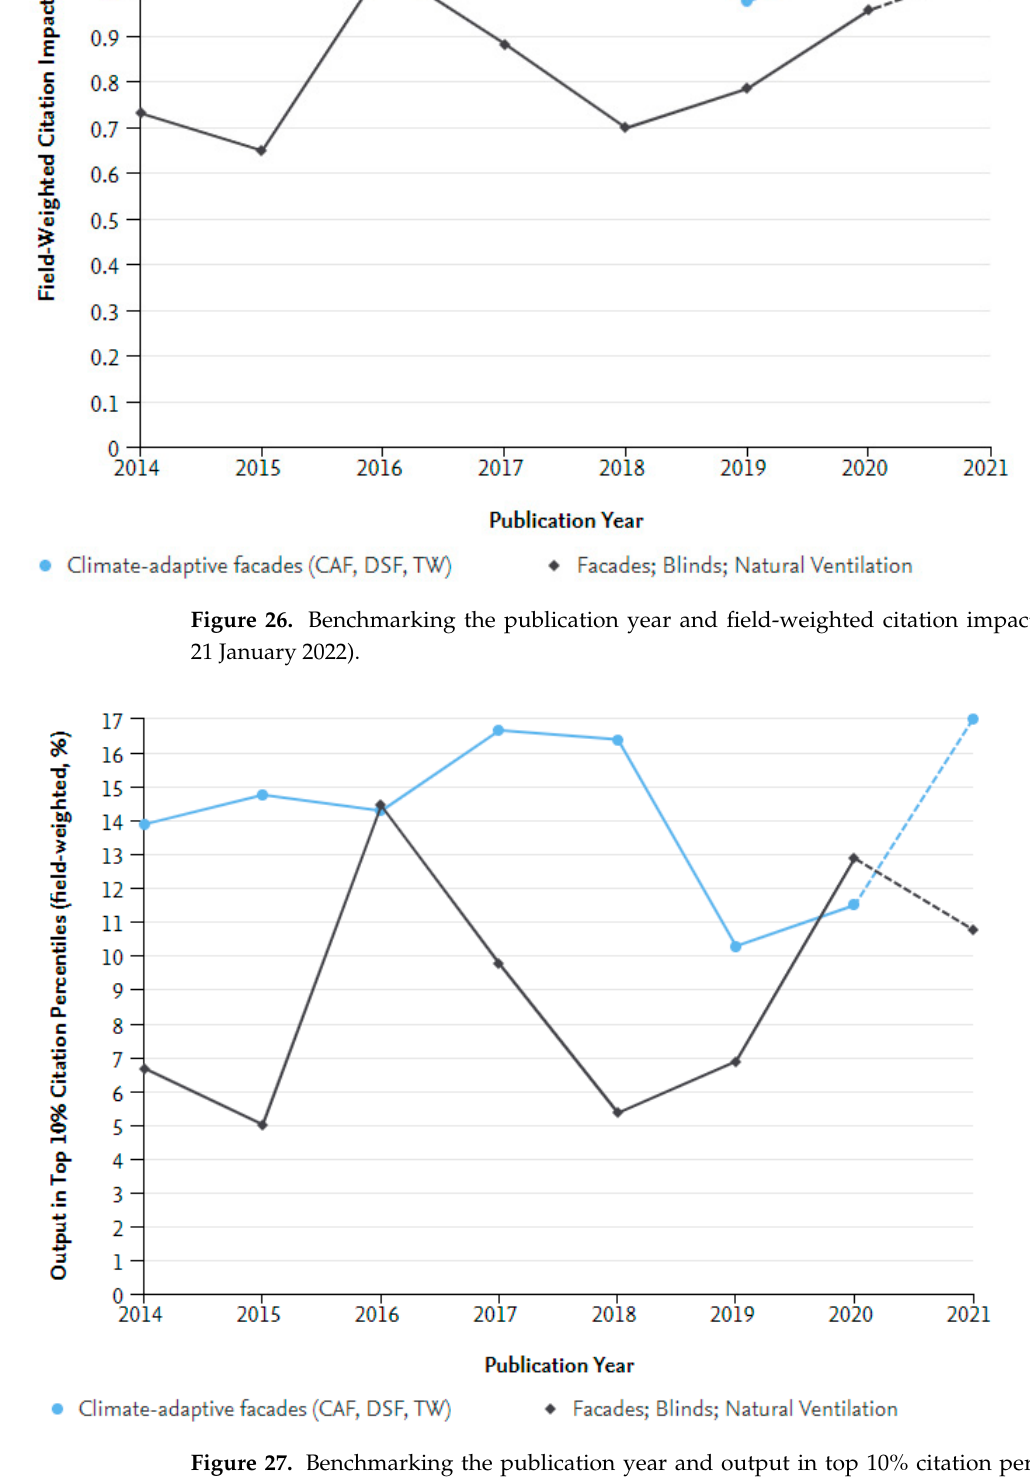
Figure 27. Benchmarking the publication year and output in top 10% citation percentiles (field- weighted, %) (accessed on 21 January 2022).